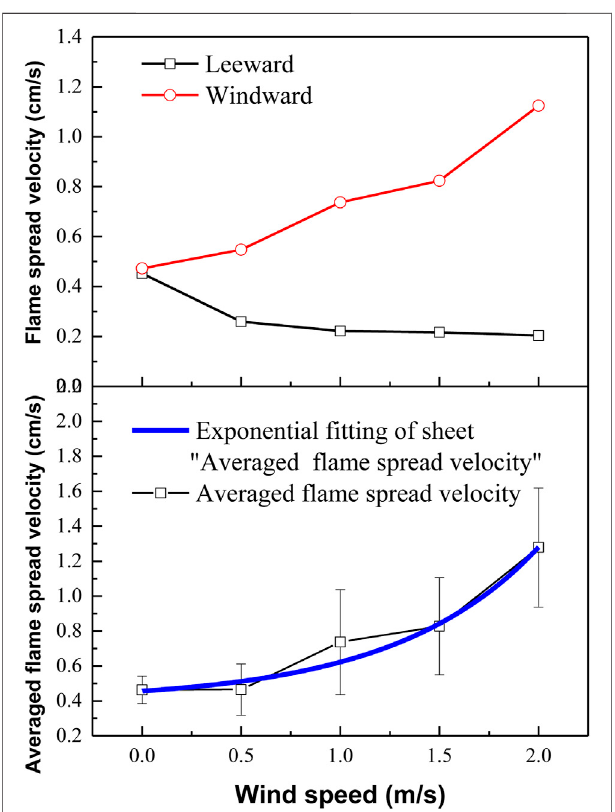
FIGURE 8 | Flame spread velocity of the FPU in relatively stable burning under different lateral wind